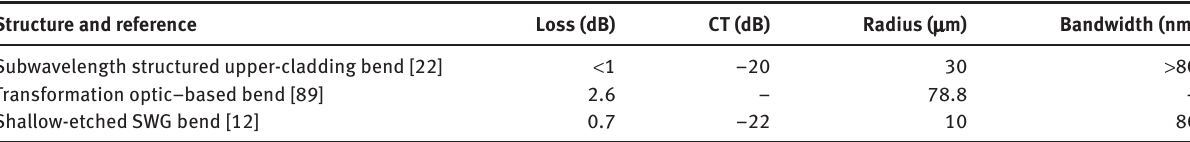
Table 5: Experimental results for some subwavelength structured bends. Structure and